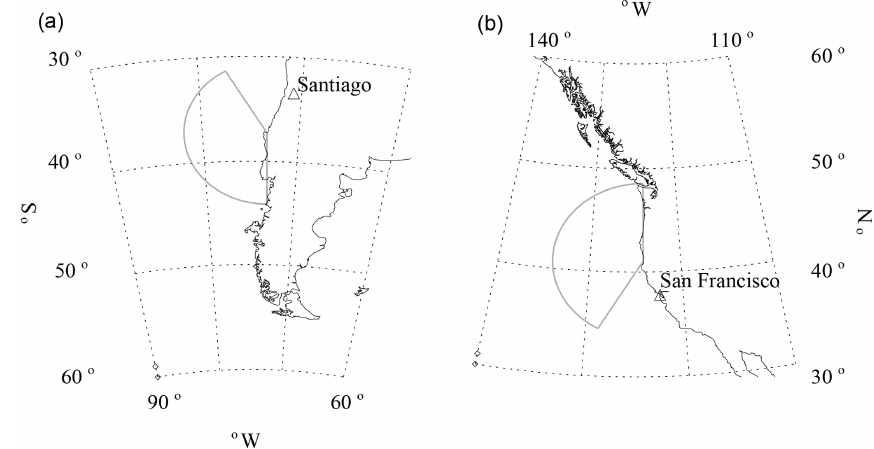
Figure 2. Clean sector chosen for Arauco ( a , 180 to 330 ◦ ) and the clean sector chosen for THD ( b , 210 to 360 ◦ ).